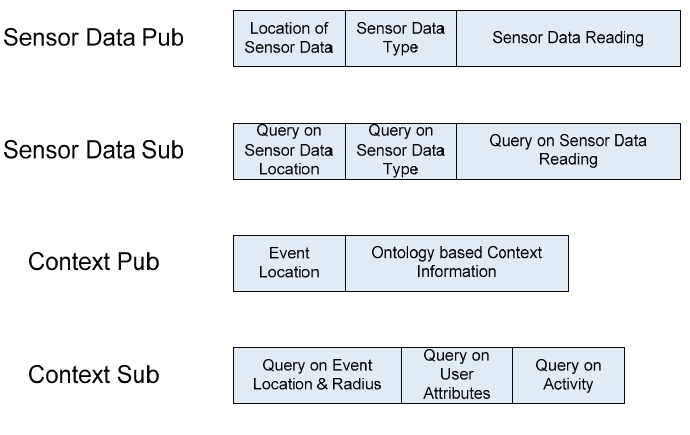
Figure 3. Data structures for bi-directional Pub/Sub.